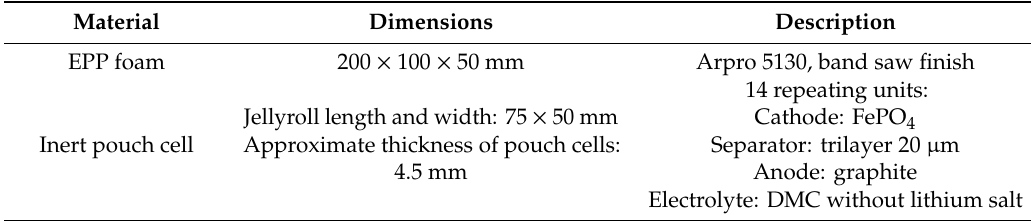
Table 1. Summary of Expanded Polypropylene (EPP) foam materials by experimental